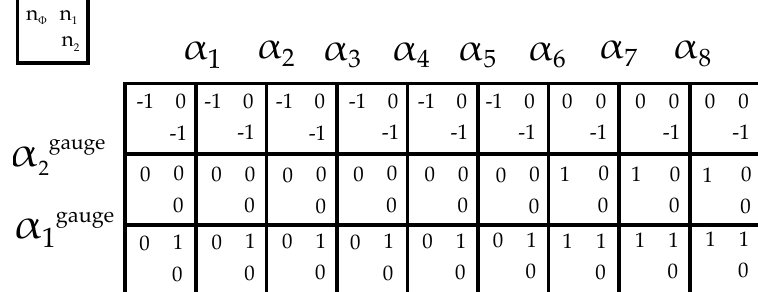
Figure 26. The pairings n l = h (cid:11) _ ; L i between the ( 3 ; 9 )-weights L and the coroots (cid:11) _ that are l l not part of U(9) BG . For any decoration of this box graph, these numbers encode via (7.4) the geometric intersections with additional non-compact divisors D (cid:8) over the a(cid:14)ne E 8 and SU(2) l (cid:12)bers. Speci(cid:12)cally, n (cid:8) denotes the pairing with the coroot D (cid:8) (the additional E 8 coroot), and n 1 ;